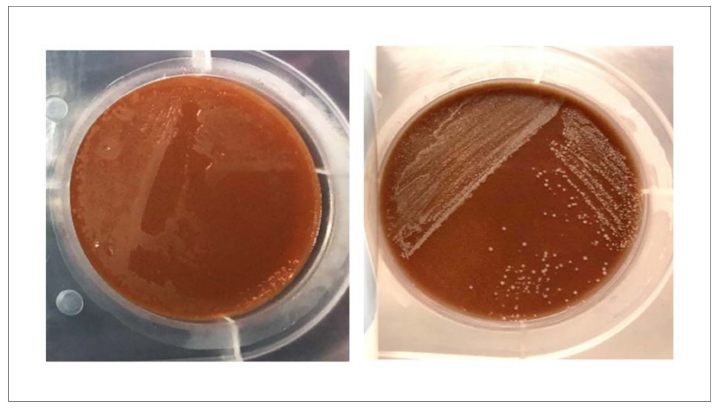
Figure A2. Comparison of subcultures of S. aureus on InTray MH Chocolate agar before ( left ) and after ( right ) optimisation of InTray subculturing